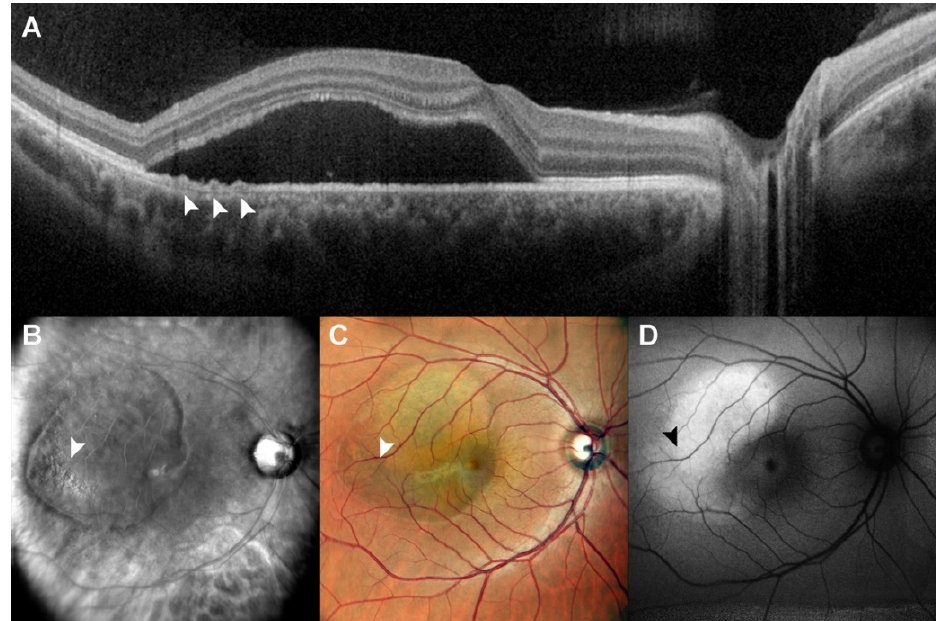
Figure 1. Patient with central serous chorioretinopathy assesed by multimodal imaging (I). A patient with central serous chorioretinopathy is assessed by spectral domain optical coherence tomography (SD-OCT) ( A ), scanning laser ophthalmoscopy (SLO) retromode imaging ( B ), SLO color fundus imaging ( C ) and fundus autofluorescence (FAF) ( D ). In this case, we have an extended amout of SRF, which creates hyper-autofluorescence signalling in FAF, covering a mild RPE dystrophy temporally to fovea (arrows, highlighting RPE dystrophy sseen at SD-OCT). SD-OCT was able to identify RPE elevations, while SLO retromode was able to identify RPE dystrophy despite the presence of fluid thanks to